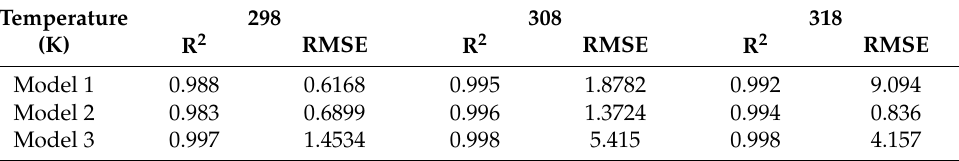
Table 4. RMSE and R 2 values for the under-study models for the system of MD on